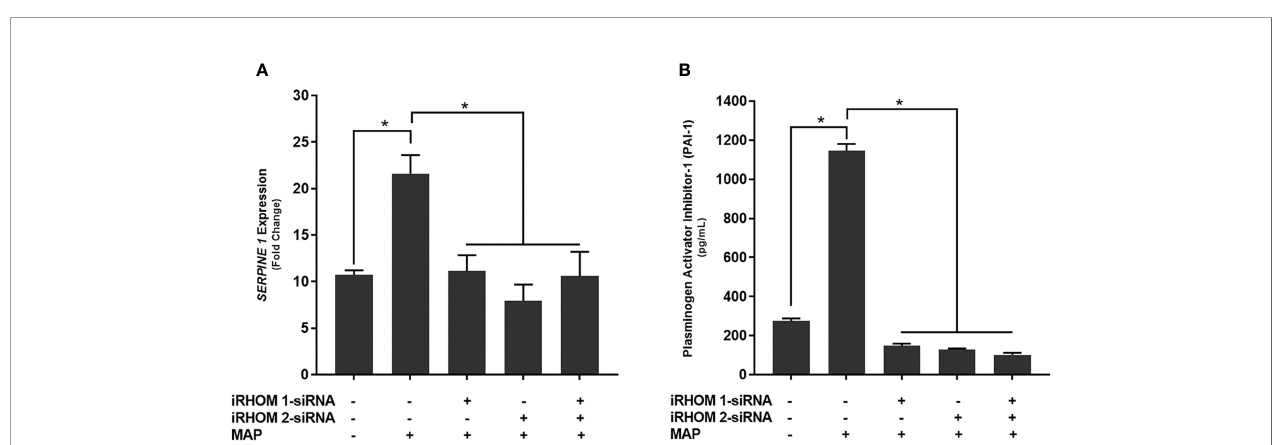
FIGURE 10 | The impact of TACE regression on the (A) expression and (B) production of plasminogen activator inhibitor-1 (PAI-1). The Kolmogorov – Smirnov normality test was used to test the normal distribution for all values and a two-way analysis of variance (ANOVA) was used to assess signi fi cance among experiments, which was followed by a Bonferroni correction test. All experiments were performed in triplicates. *Indicates P-value of less than